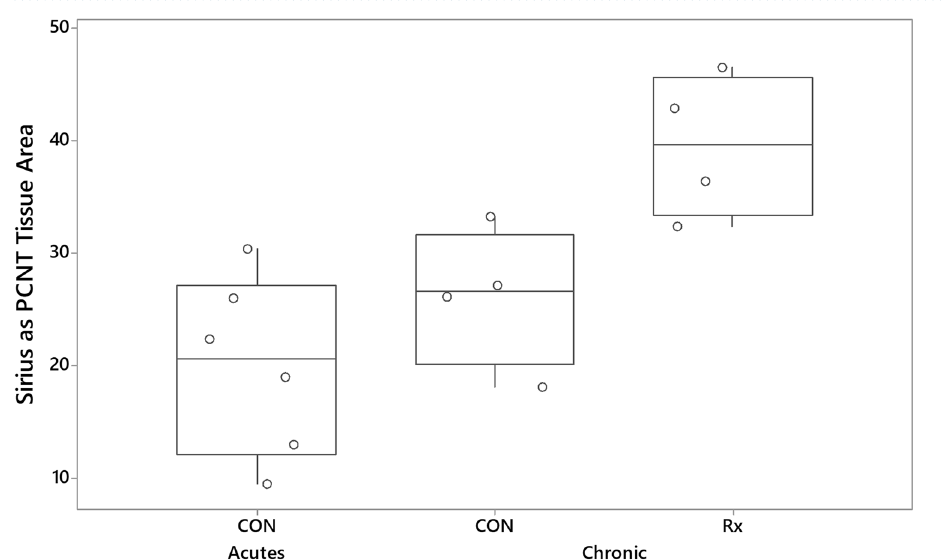
Figure 3. Boxplot illustrating Picrosirius Red stain expressed as a percentage of tissue area. Each symbol represents the average of measurements made in every available parenchymal field found in sections derived from the radio-exposed (Rx) and contralateral control (CON) lung of sheep experiencing chronic responses to radiation (Chronic), and contralateral control lungs of six sheep experiencing acute responses to an identical radiotherapy protocol (CON, Acutes; 23 days after the last radiation dose). The data illustrates an increase in collagen in the radio-exposed lung (Picrosirius Red stain). The top of each box represents the third quartile and the bottom the first quantile, the upper and lower whiskers extend to the highest and lowest data values within the upper and lower limits, respectively, and the central line represents the